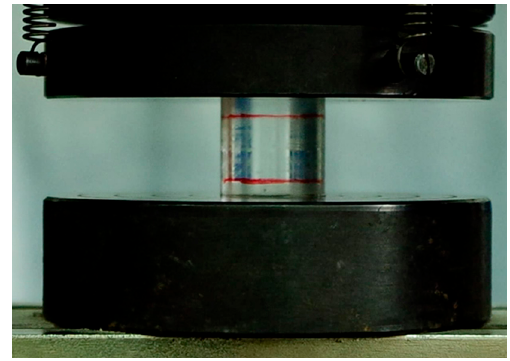
Figure 1. A specimen under quasi-static compression.